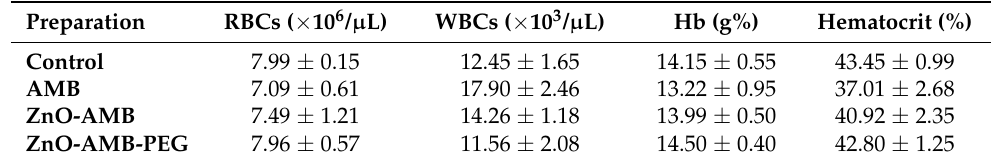
Table 3. Hematological parameters on post-injection effects. Preparation